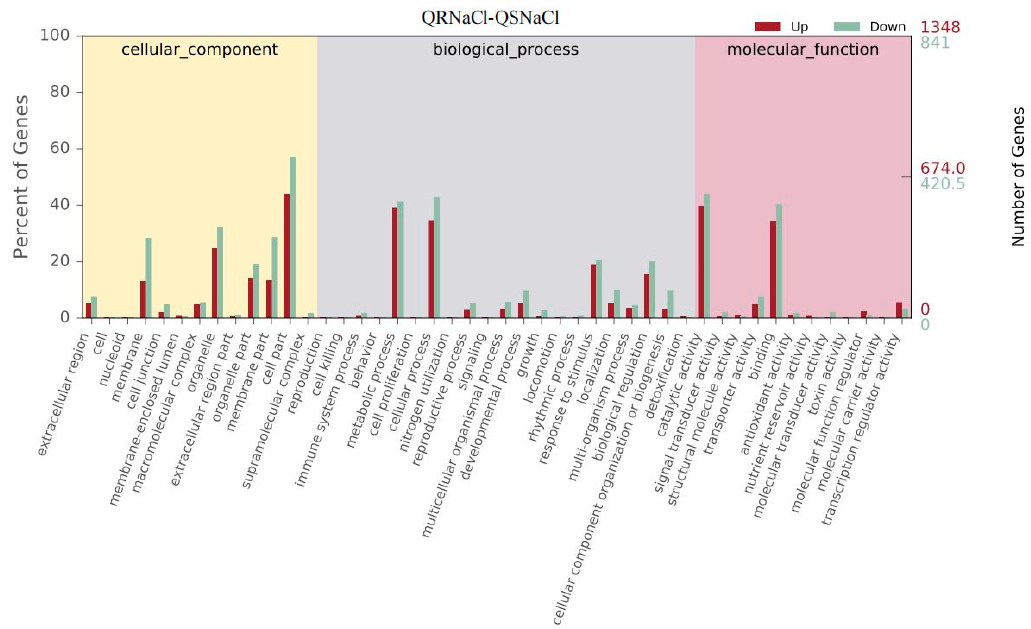
Figure 7. Gene Ontology (GO) analysis of the DEGs between two E. crus ‐ galli populations treated with 50 mM NaCl. GO analysis was performed at level 2 for the three main categories. with 50 mM NaCl. GO analysis was performed at level 2 for the three main